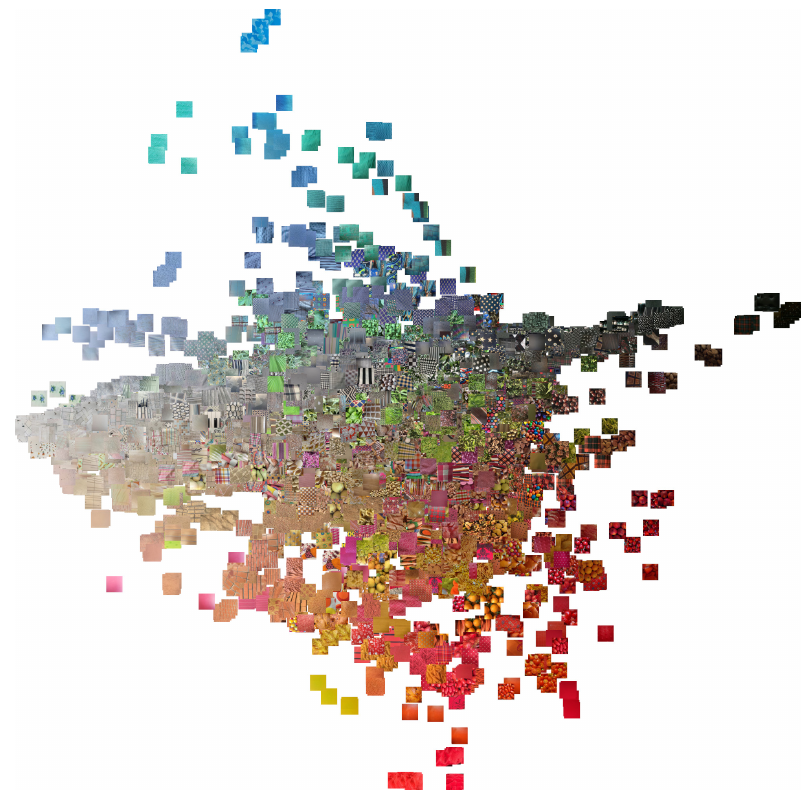
Figure 5. Result of the application of t-SNE to the image pixels.